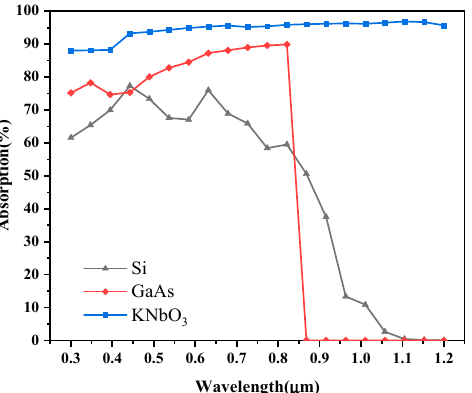
Figure 1. The absorption of various semiconductor materials in the wavelength from 0.3 to 1.2 μ m.